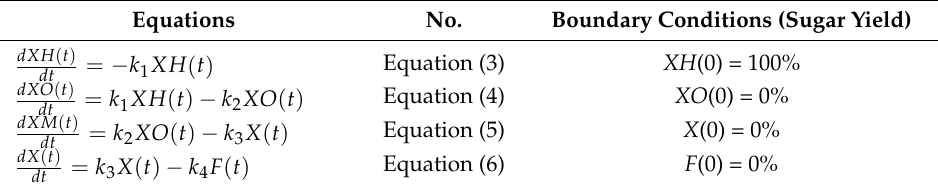
Table 5. Kinetic equations developed from Equation